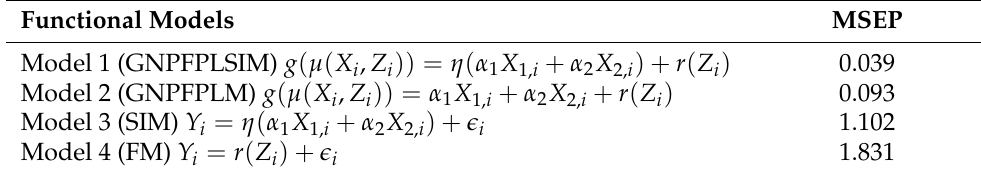
Table 14. The MSEPs for different models: logistic